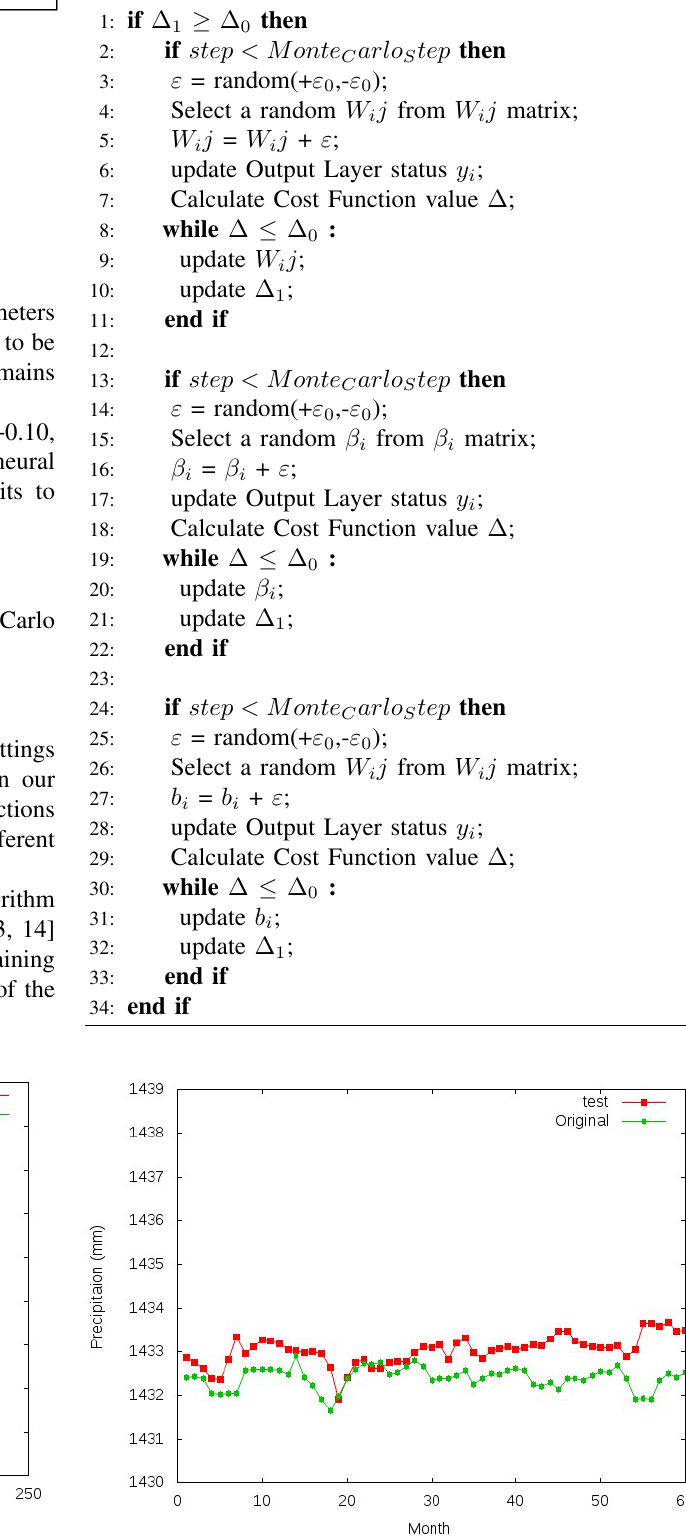
Fig. 3: Training on Back Propagation algorithm